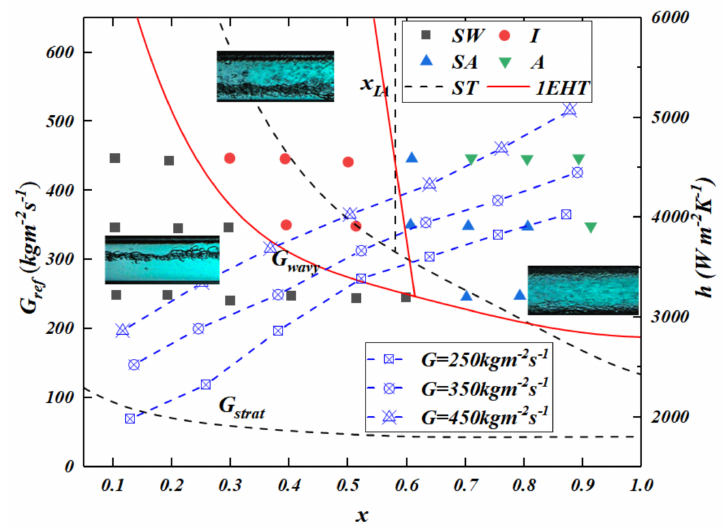
Figure 11. Flow patterns and HTC of the three-dimensional enhanced copper 1EHT heat transfer tube at different mass flow